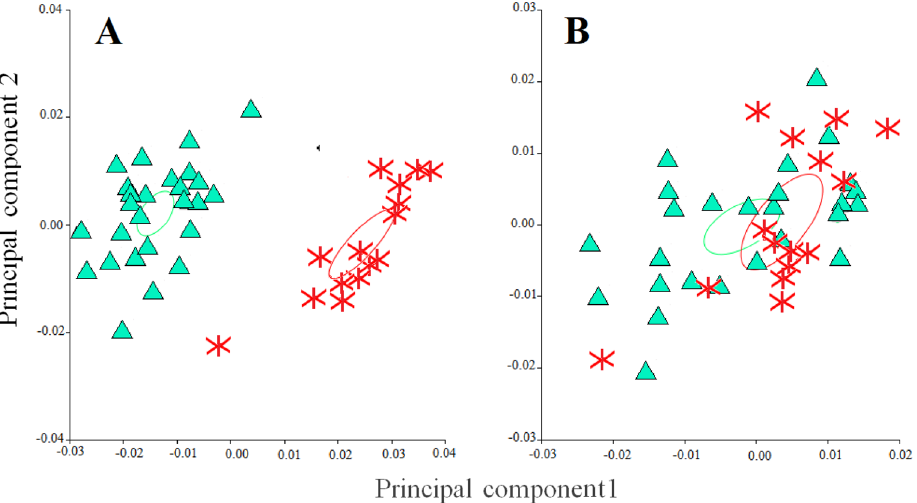
Figure 5. Plot of the Procrustes values for L. niitkib (triangles) y Lestrimelitta sp. (asterisks) against components 1 and 2, including 90% confidence ellipses, in: (A) with the effect of size and (B) regression corrected to represent differences in the shape of the